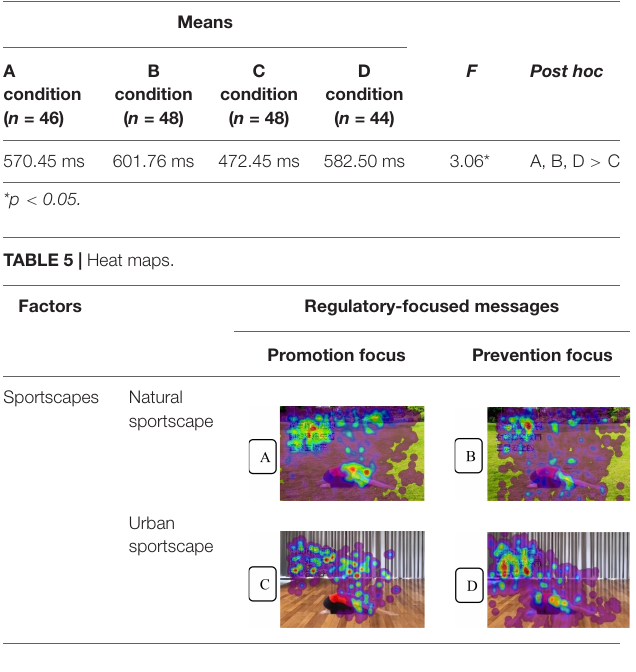
TABLE 6 | Behavioral intention of older consumers under the four